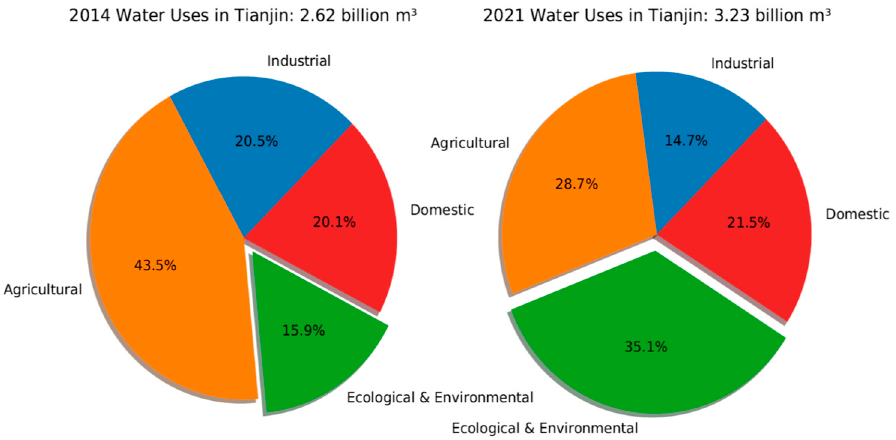
Figure 4. Water uses in Tianjin during 2014 and 2021. The South-to-North Water Diversion (SNWD) project began to divert Yangtze water to Tianjin at the end of 2014. (Data source: Tianjin Water Resources Bulletin, 2014 and 2021 [10]).